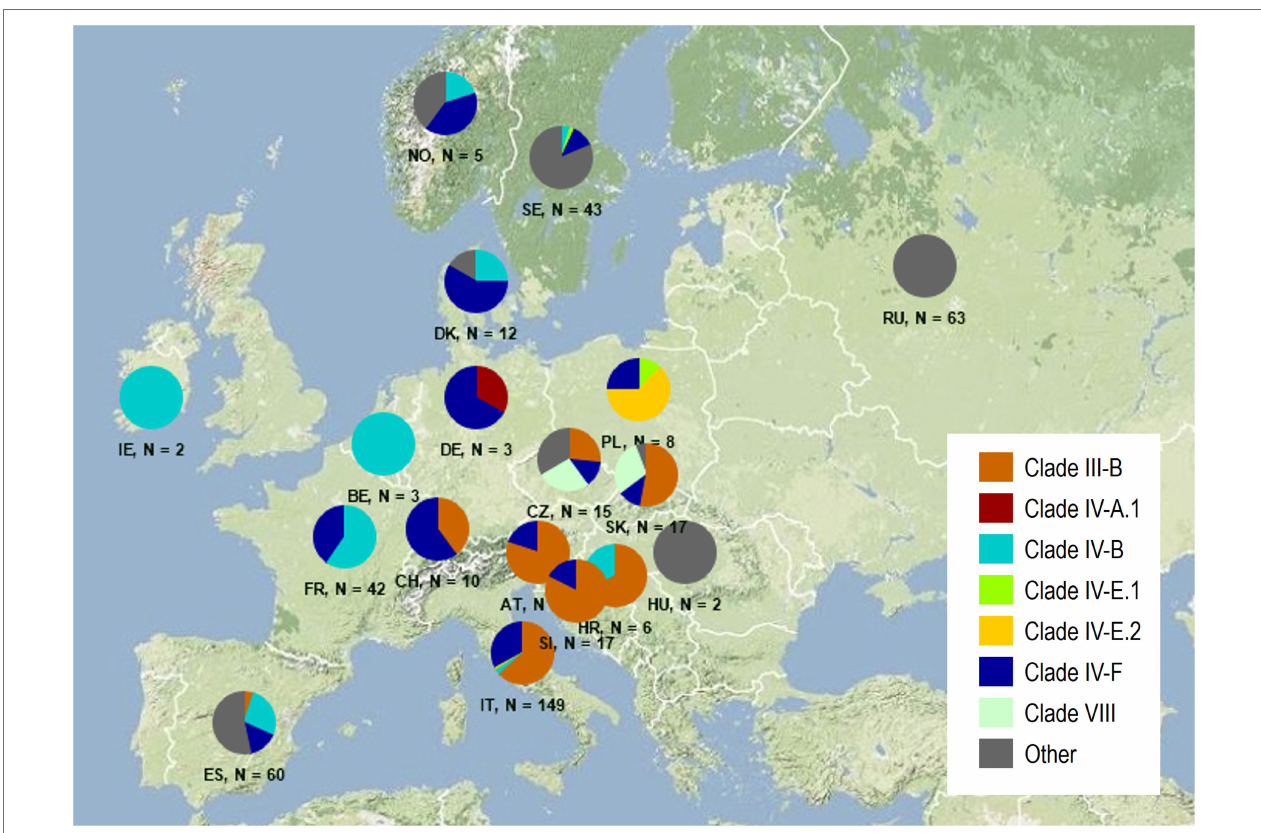
FIGURE 2 | Frequency distribution of genetic groups among 459 isolates of Puccinia graminis f. sp. tritici in Europe between 2016 and 2021. The designation of distinct groups follows the nomenclature suggested by Szabo et al. (2022). ‘Others’ refer to genetic groups, which have not yet been named internationally. Downloaded 3 February 2022.